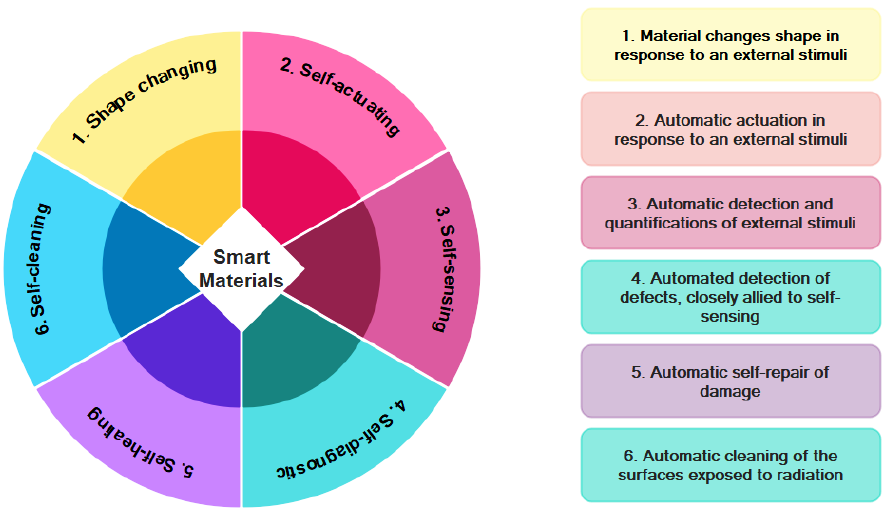
Figure 1. Smart functions added to the structural materials and their capabilities.